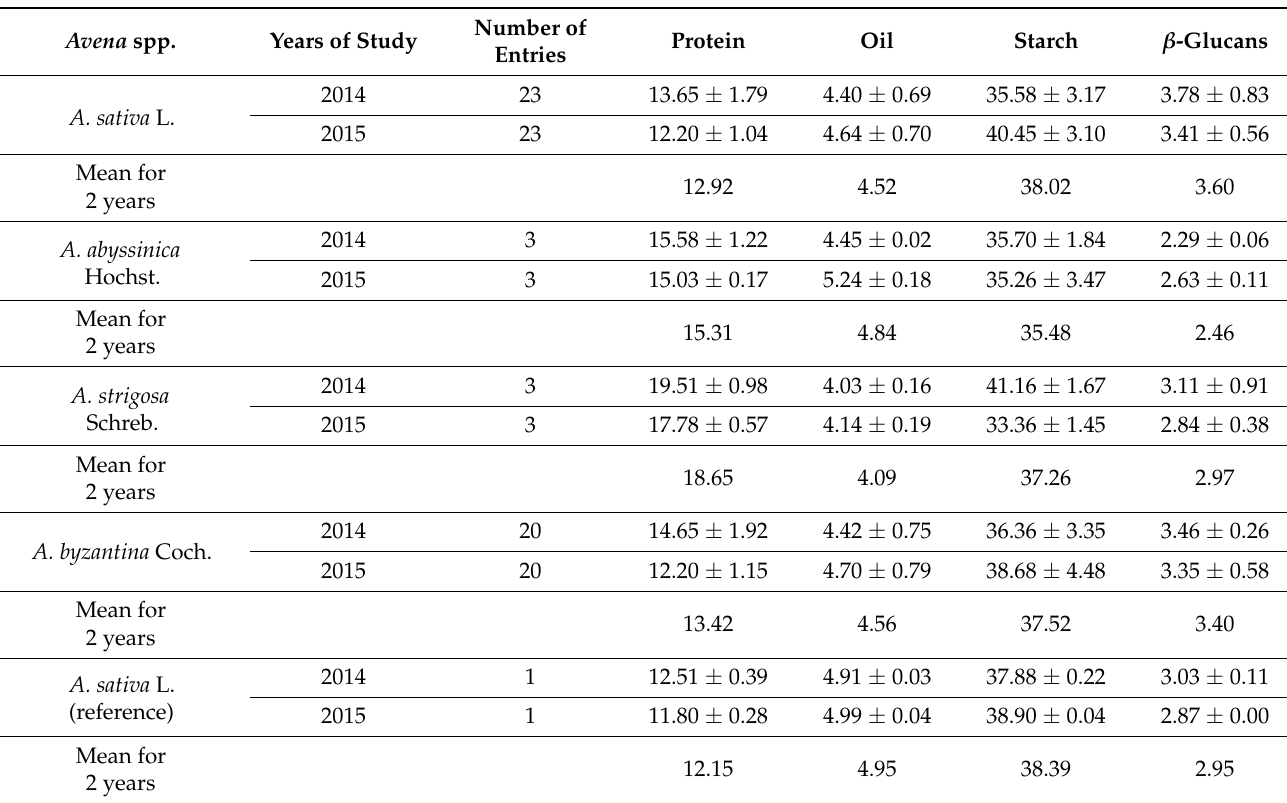
Table 1. Average values of protein, starch, oil and β -glucan content in Avena L. grain accessions from the VIR collection, in % DW (dry